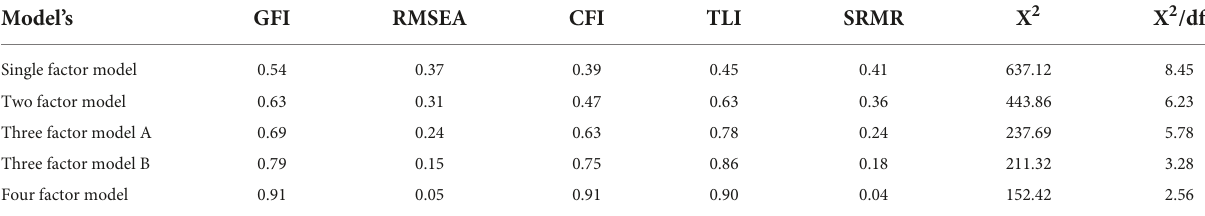
TABLE 1 Results of confirmatory factor